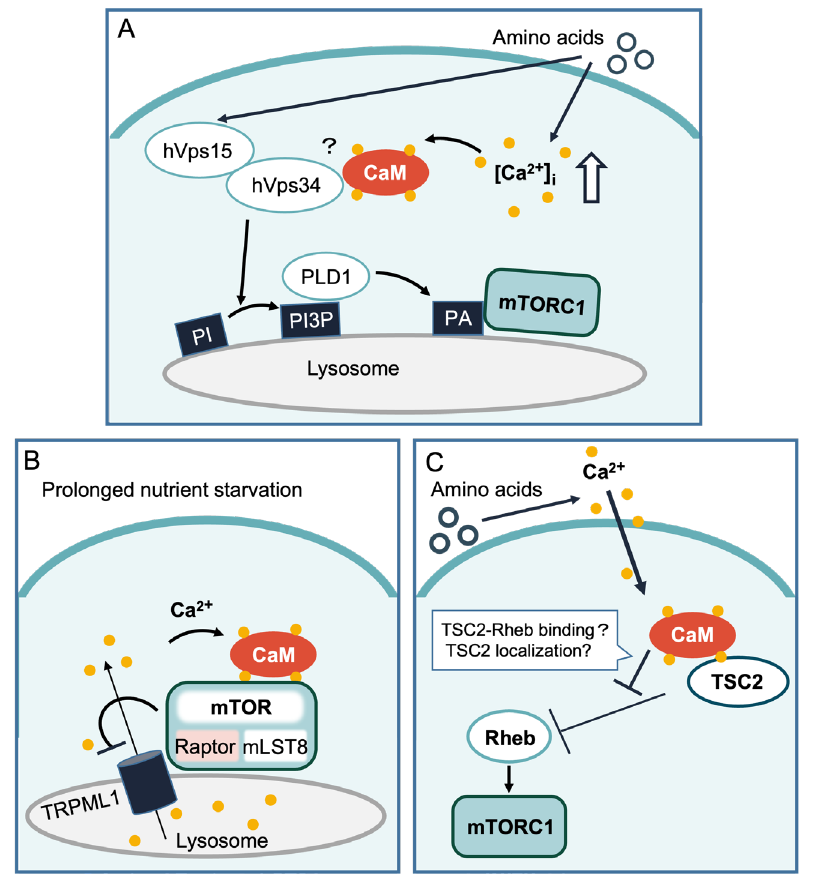
Figure 2. Ca 2+ /CaM-mediated regulation of mTORC1. ( A ) Amino acids have been reported to elevate intracellular Ca 2+ concentration and enhance hVps34 kinase activity by promoting the binding between hVps34 and CaM in a Ca 2+ -dependent manner. hVps34 has also been suggested to be activated by amino acids by binding to hVps15. Activated hVps34 generates PI3P from PI in the lysosome, which can trigger PLD1 recruitment. PLD1 then produces PA, which leads to mTORC1 activation. ( B ) The lysosomal Ca 2+ channel TRPML1 is negatively regulated by mTORC1. Prolonged nutrient starvation may decrease mTORC1 activity and relieve its inhibition. TRPML1-mediated Ca 2+ release from the lysosome is sensed by CaM and might activate mTORC1 by the direct binding of Ca 2+ /CaM to mTOR. ( C ) Amino acids provoke extracellular Ca 2+ influx. Ca 2+ /CaM activates mTORC1 through the TSC2–Rheb axis by binding to and inhibiting TSC2. Binding of Ca 2+ /CaM to TSC2 might affect TSC2 actions by affecting TSC2 binding to Rheb and/or TSC2 localization, although the detailed mechanism of how Ca 2+ /CaM suppresses TSC2–Rheb remains unclear. Ca 2+ is indicated by yellow circles.